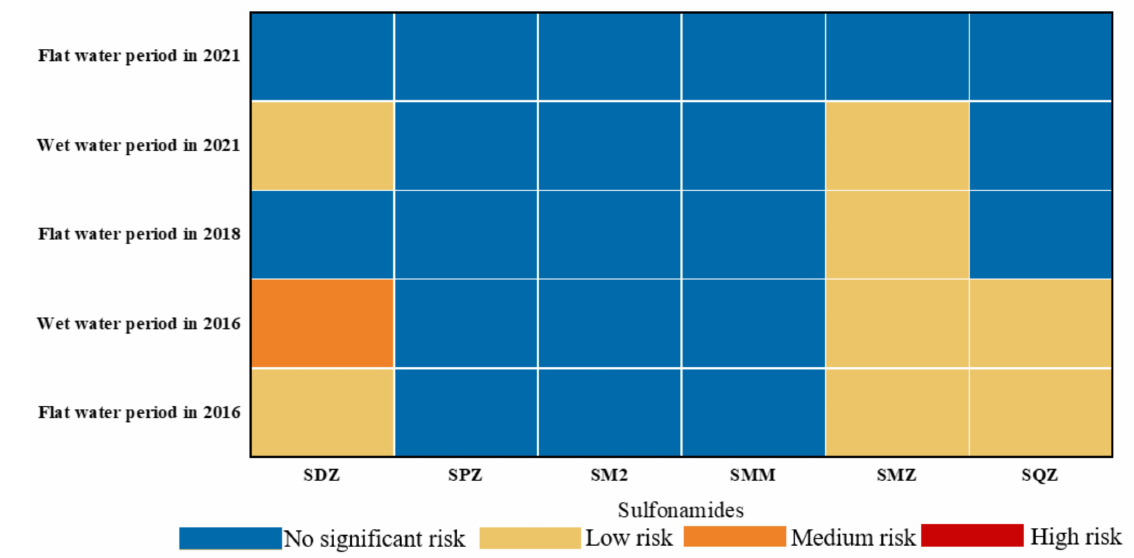
Figure 8. Comparison of the RQ s of sulfonamides in Shaanxi section of the Weihe River from 2016 to